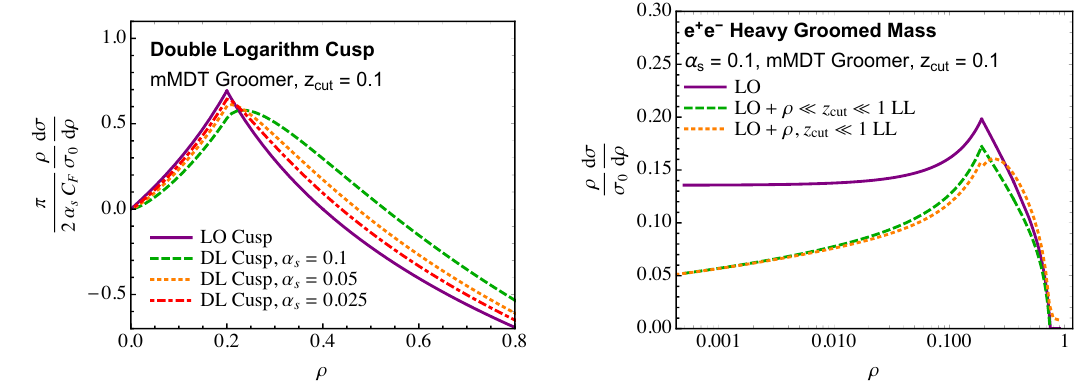
Figure 4 . Left: plots of the double-logarithmic resummed distribution eq. (5.10) about the cusp for various values of α . Also plotted is the leading-order distribution from eq. (4.4). Right: s comparison of the leading-order (LO), leading-order matched with ρ (cid:28) z 1 resummation, and cut (cid:28) subsequently then matched with ρ ∼ z 1 cut (cid:28)